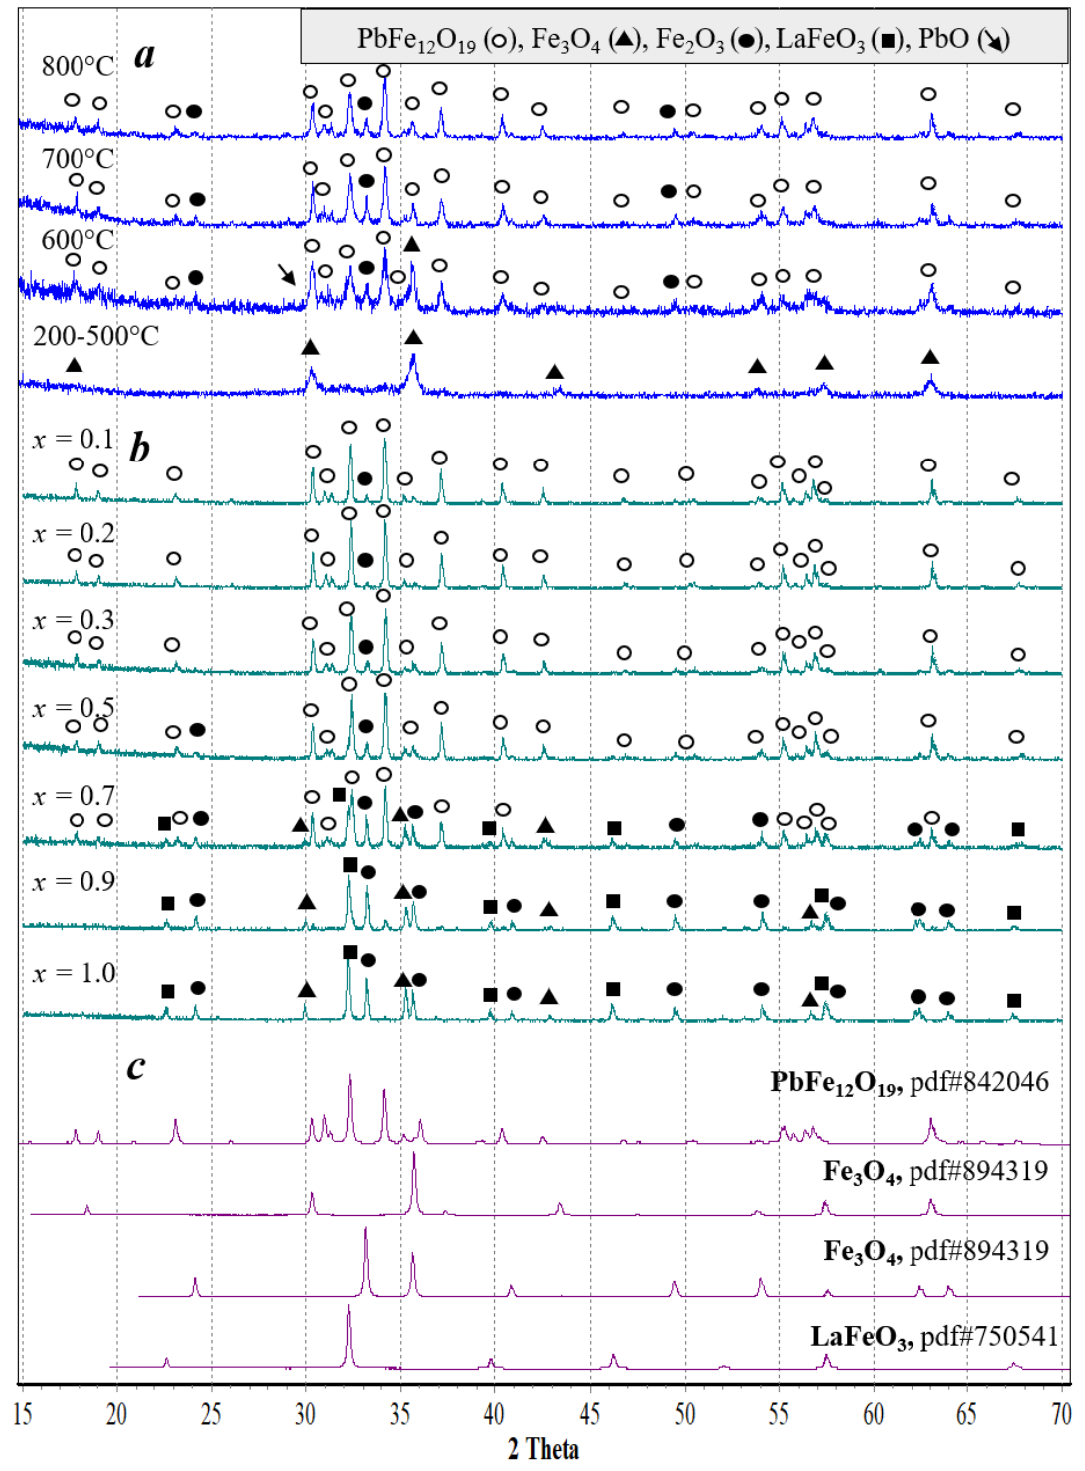
Figure 5. Diffraction patterns of the products obtained by the gel method: ( a ) PbFe 12 O 19 after the calcination at various temperatures, ( b ) Pb 1− х La х Fe 12− x Zn x O 19 after the calcination at 800 °C, and ( c ) diffraction profiles of some oxide phases from the ICDD base (for comparison).